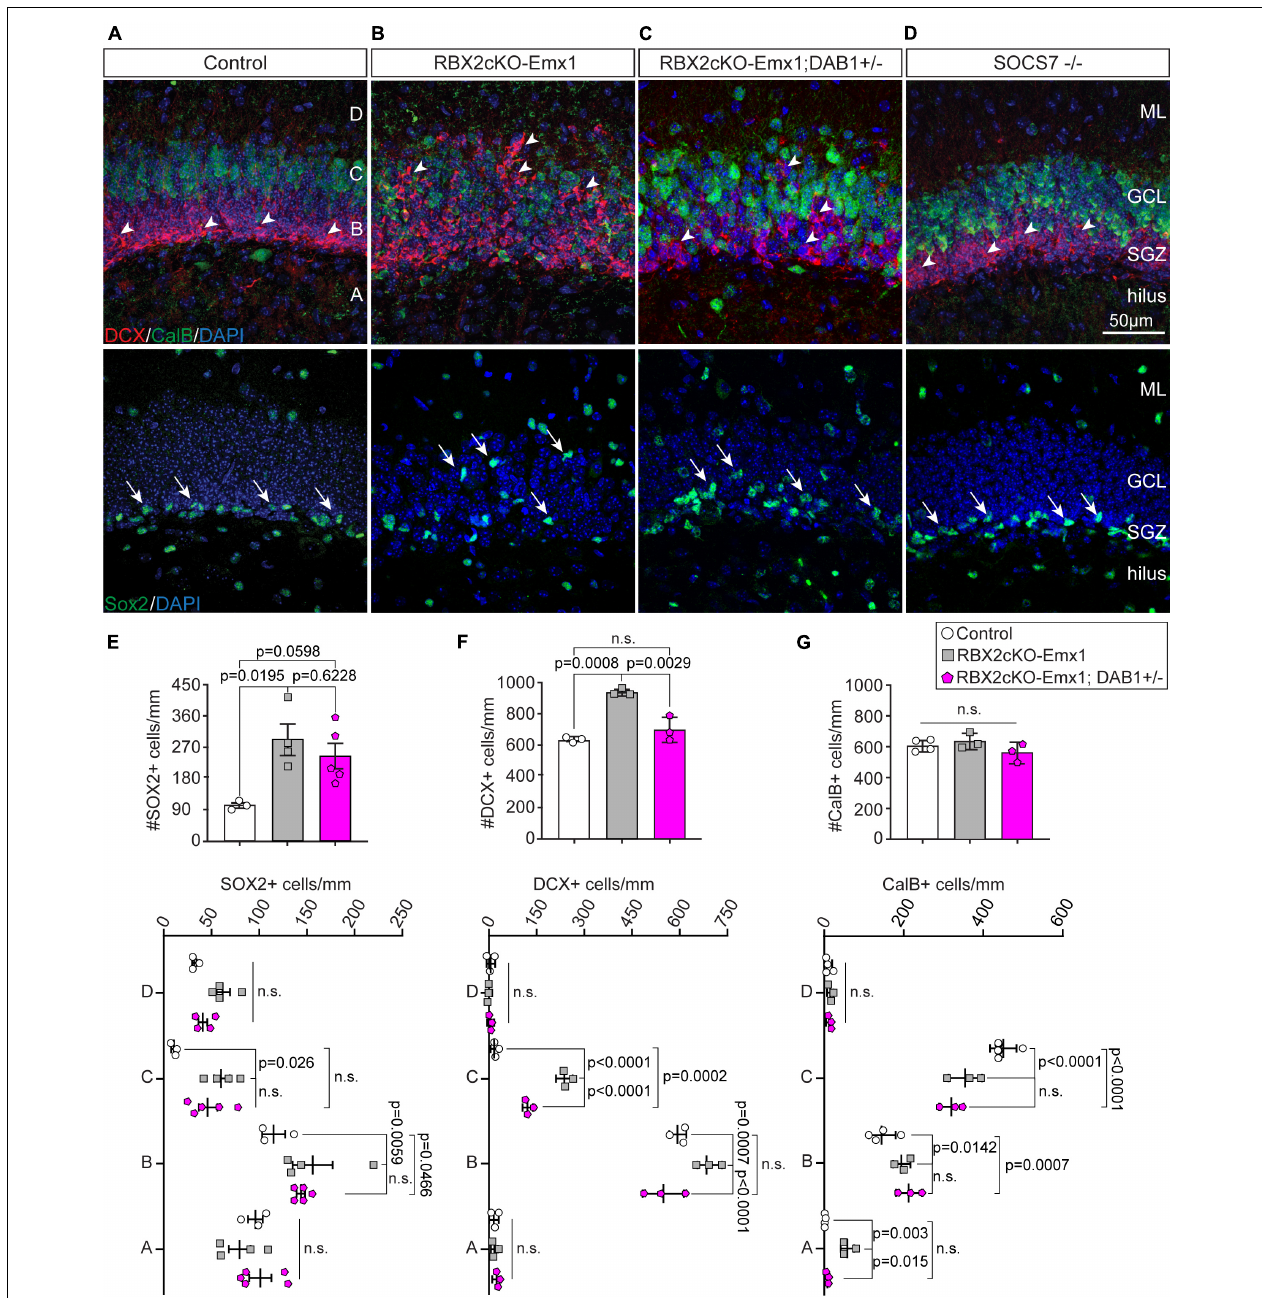
FIGURE 2 | RBX2 regulates layering during DG development and controls NSC proliferation. (A,B) Depletion of RBX2 disrupted the localization of Doublecortin (DCX)+ (arrowheads) and calbindin (CalB)+ cells in comparison to control DG at P21. Similarly, SOX2+ NSCs, which normally locate in the subgranular zone (SGZ), were displaced to other areas of the DG upon RBX2 depletion. (C) Reducing DAB1 accumulation partially rescued the localization defects of DCX+ cells caused by knocking out RBX2, whereas it had little effect in CalB+ and SOX2+ cells. (D) Knocking out SOCS7 did not affect the neuron localization and layering in the DG. Total number (top) and layer distribution (bottom) of SOX2+ (E) , DCX+ (F) , and CalB+ (G) cells in the DG. The DG was divided in four layers as shown in (A) . Mean ± SEM. Statistics, one-way ANOVA with Tukey’s method adjusted p -value for total number of cell analyses and two-way ANOVA with Tukey’s method adjusted p -value for layering analyses. ML, molecular layer; GCL, granule cell